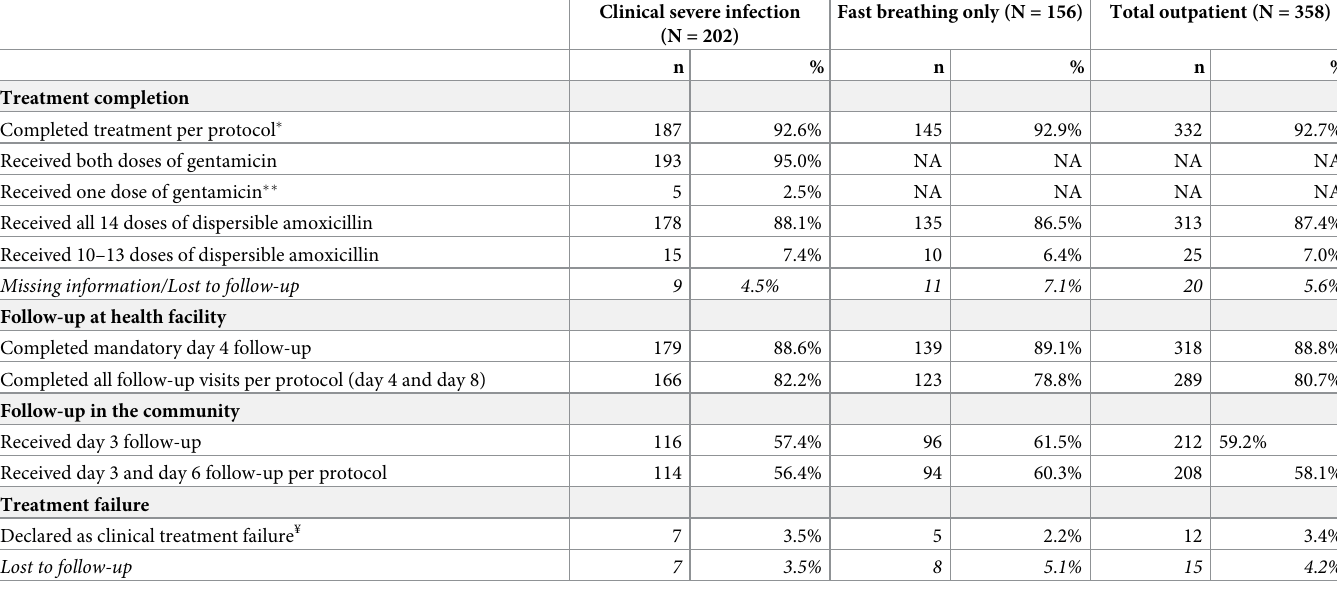
Table 3. Treatment outcomes and follow-up completion by case type among those who received outpatient treatment (n =